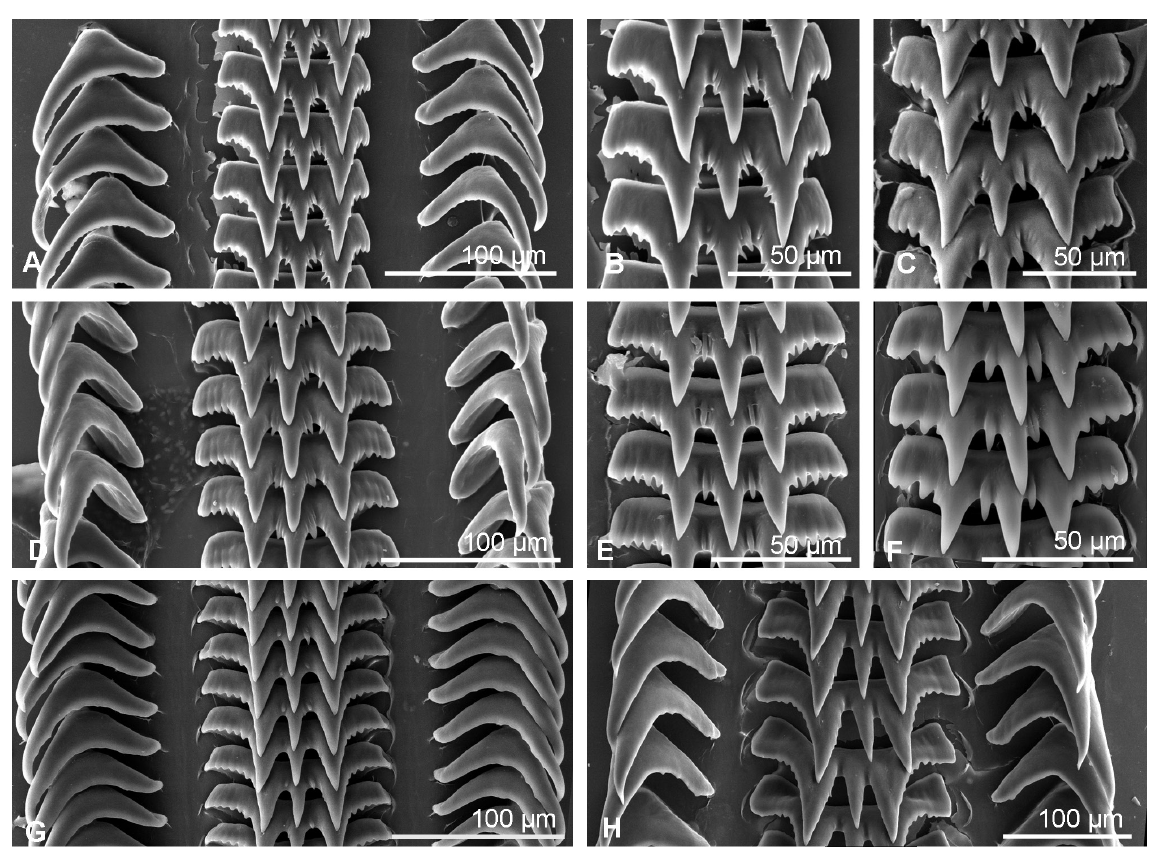
Fig. 13. Radulae of species of Amalda H. Adams & A. Adams, 1853. A–C . A.